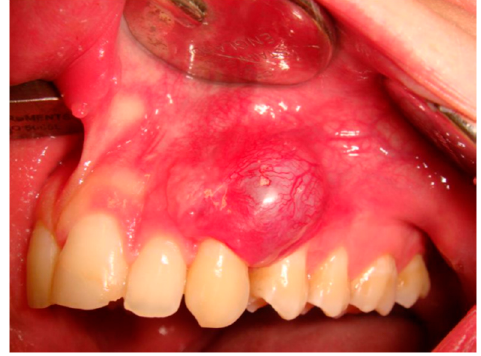
Figure 1. Soft red-violet swelling of the adherent gingiva in a 17 y.o. male patient.